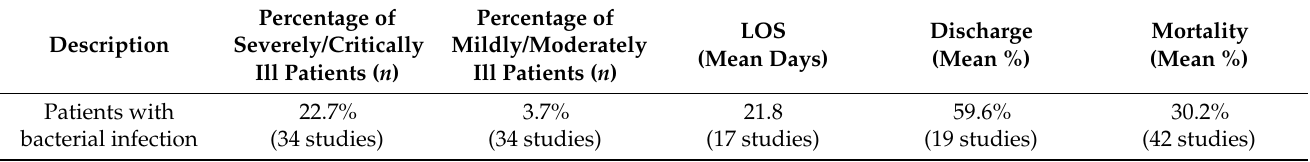
Table 10. Severity of illness, bacterial infection rate and health outcomes in COVID-19